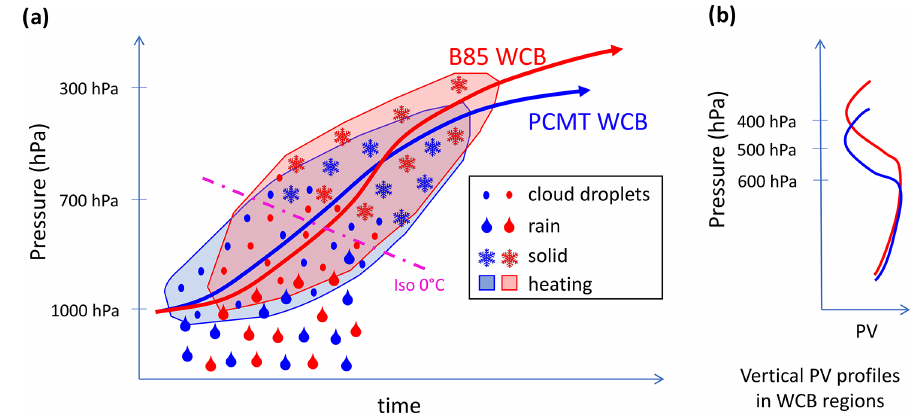
Figure 12. Schematic representing differences between the two convection schemes in latent heating and PV